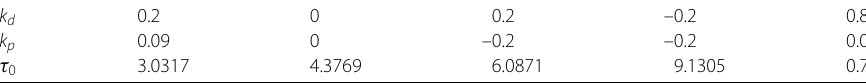
Table 1 The values of τ 0 of the PD control Euler method k d 0.2 0 0.2